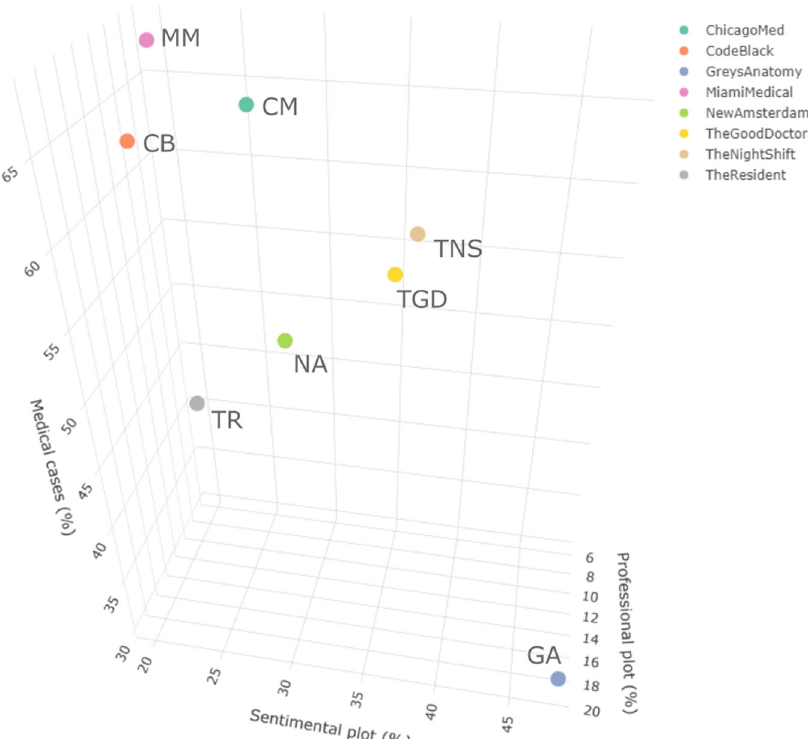
Fig. 2 Spacial classi fi cation of the eight series. The dots identify in space the characteristics of the eight medical series under preliminary investigation considering the average percentage for the three isotopies identi fi ed within the genre (sentimental plot, professional plot, medical cases). Table 2 Each series is de fi ned by a vector of four percentage values indicating the mean time occupied by the isotopies (i.e. PP, SP, MC and